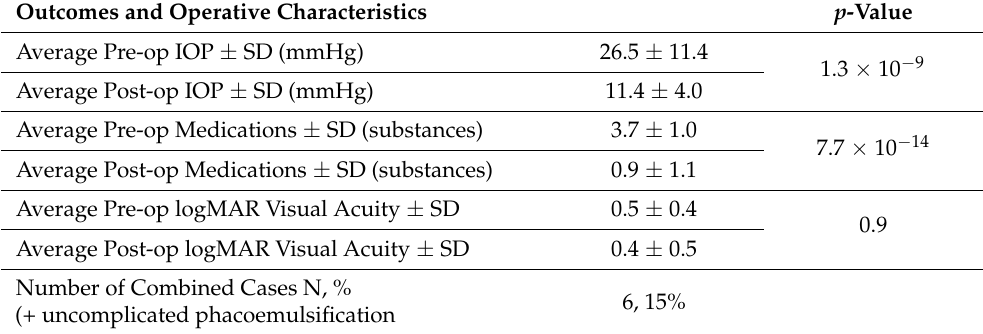
Table 2. Pre-operative characteristics and operative outcomes of the cohort at the last available follow-up visit. Post-op data are in reference to the last available visit and are censored at the time of re-operation for glaucoma. p -values refer to statistical comparison by the paired t -test in all instances. Outcomes and Operative Characteristics p -Value Average Pre-op IOP ± SD (mmHg) 26.5 ±